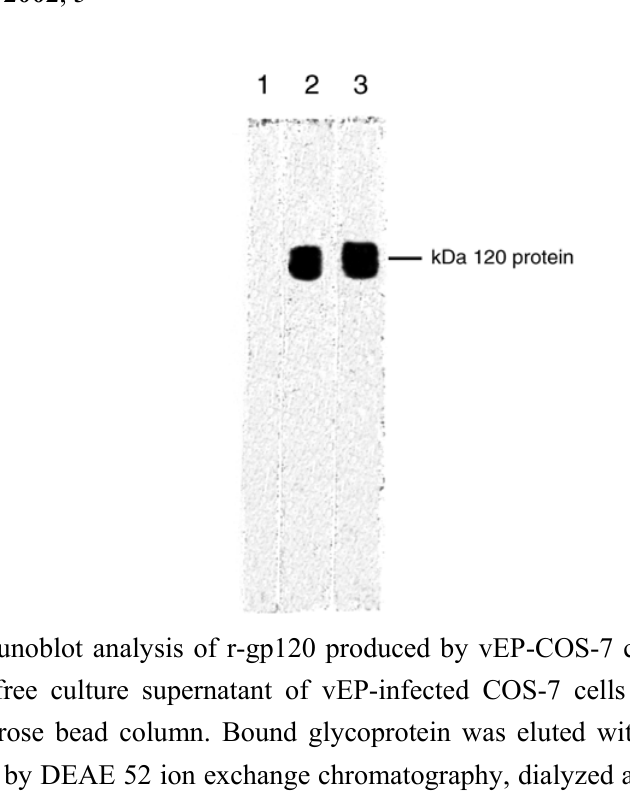
Figure 2. CD4-precipitation of [ 3 H]methionine-labeled mutant r-gp120 with deleted NH amino acids. Cell culture supernatant was cleared of debris by ultra-centrifugation, concentrated and incubated with agarose beads conjugated to soluble CD4 overnight. After PBS washing, the beads were boiled in 2X SDS-PAGE loading buffer, and the supernatant analyzed in 10% PAGE, followed by auto-radiography of the dried gel. Lane 1: control untransfected COS-7 cells; Lane 2: mutant r- gp120 expressed in COS-7 cells; Lane 3: insect cells not infected with recombinant baculovirus; Lane 4: mutant r-gp120 expressed in insect cell/baculovirus